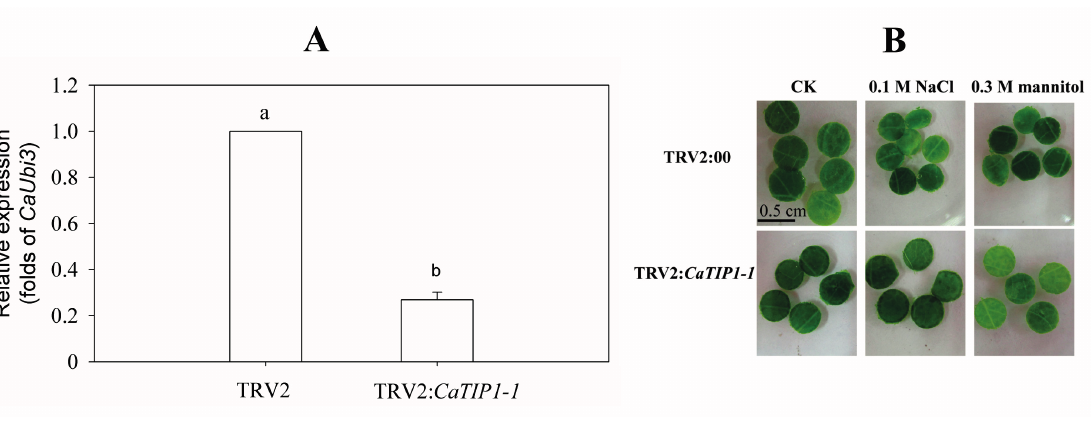
Figure 8. CaTIP1-1 expression level of gene-silenced pepper plants. ( A ) The expression of CaTIP1-1 in gene-silenced pepper (TRV2: CaTIP1-1 ) cv P70 and control plants (TRV2:00) were tested at 45 days after inoculation; ( B ) leaf discs phenotypes (0.5 cm in diameter) of the gene-silenced plants in response to 0.1 M salt stress and 0.3 M mannitol stress after 48